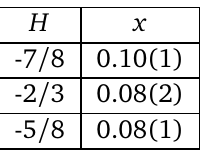
∼ 0.104 when H < − 1 / 2. f